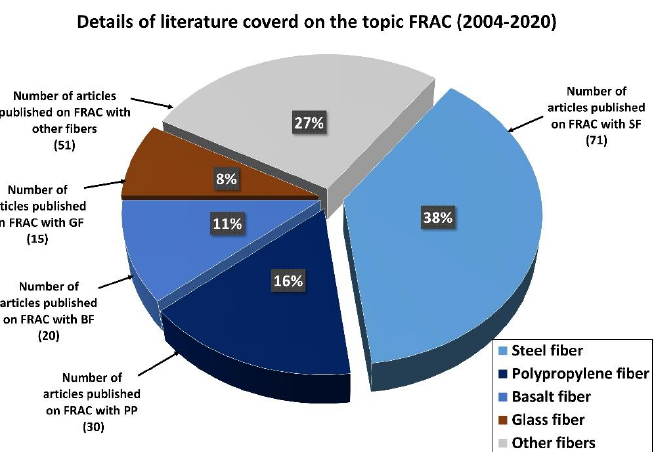
Figure 8. Details of literature data (2004–2021) on recycled aggregate concrete produced with fre- Buildings 2022 , 12 , x FOR PEER REVIEW quently used fibers such as SF, PP, BF, and GF and all other synthetic and natural fibers.